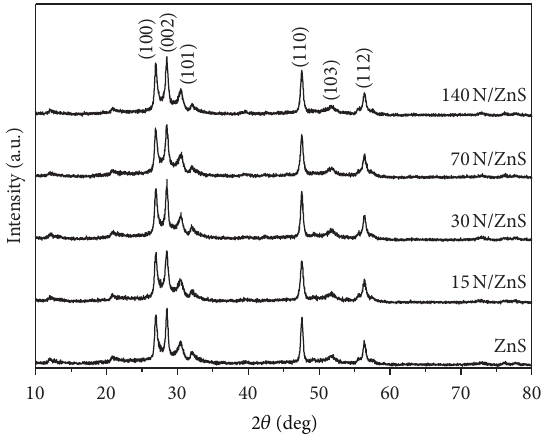
Figure 1: XRD patterns of nitrogen-doped and bare ZnS.